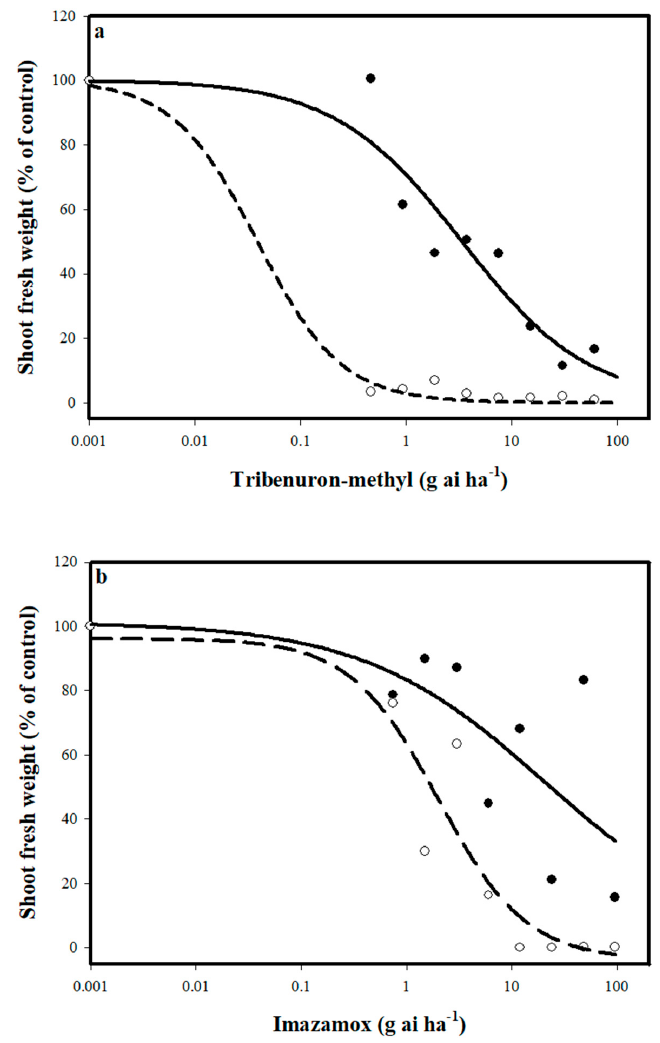
Figure 1. Effects of tribenuron-methyl ( a ) and imazamox ( b ) applied post-emergence at increasing rates on the shoot fresh weight of S (open circles) and R (closed circles) populations of Diplotaxis erucoides . Data was collected 21 days after treatment.